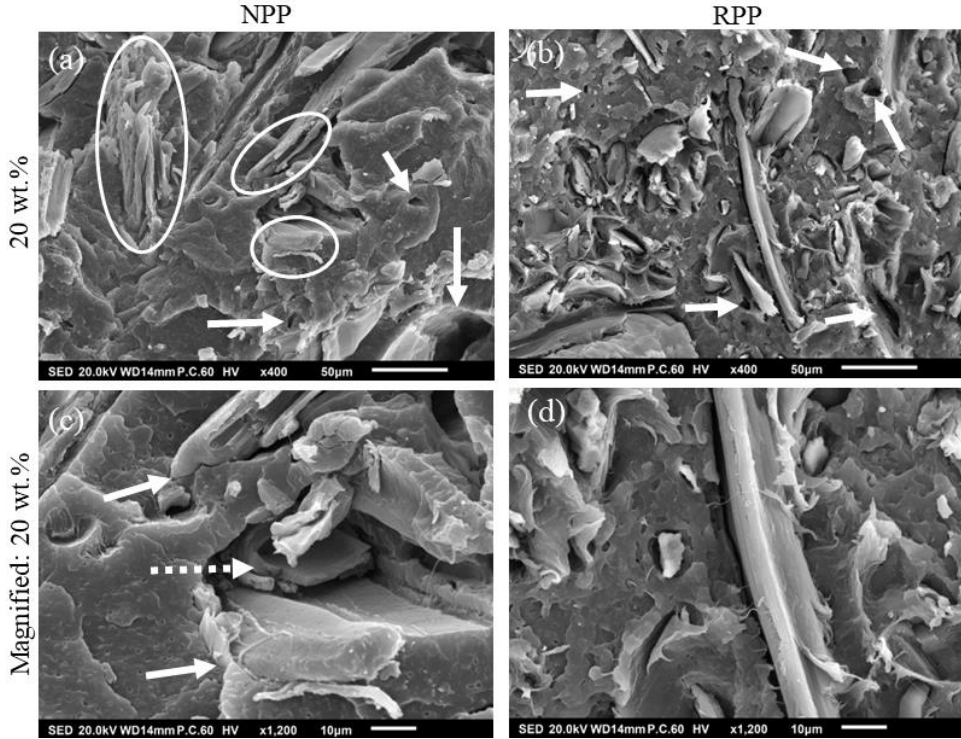
Figure 4. SEM images of fractured samples with 20 wt.% wood fibers; ( a ) neat (NPP) and ( b ) recycled (RPP) matrix and magnified images of ( c ) neat (NPP) and ( d ) recycled (RPP)